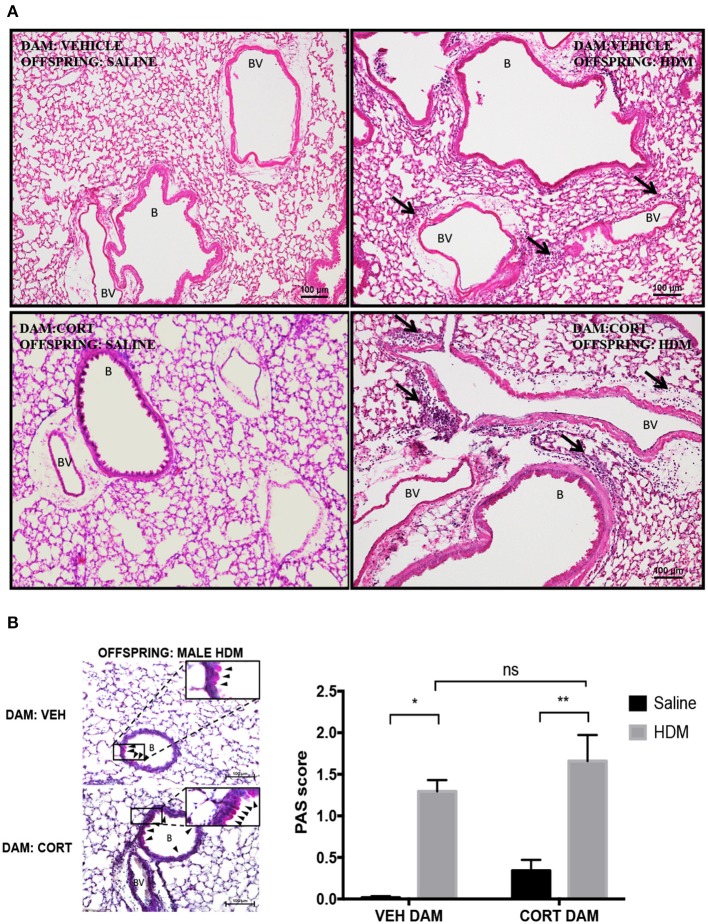
Characterization of pulmonary histopathology in male offspring from vehicle and CORT-treated dams. (A) Representative light photomicrographs of lung tissue sections from male offspring of vehicle and CORT-treated dams stained with hematoxylin and Eosin. B, bronchiolar airspace; BV, blood vessel; arrows, immune cell infiltration. (B) Goblet cell hyperplasia was quantified by scoring histological sections based on the percentage of PAS-positive cells lining the bronchoalveolar space: grade 0: <0.5%; grade 1: 0–25%, grade 2: 25–50%, grade 3: 50–75%, grade 4: >75%. B: bronchiolar airspace, BV: blood vessel, arrows: PAS+ cells, scale bar: 100 μm. The mean PAS scores were compared (*p = 0.002, **p = 0.0002) (n = 3–5).